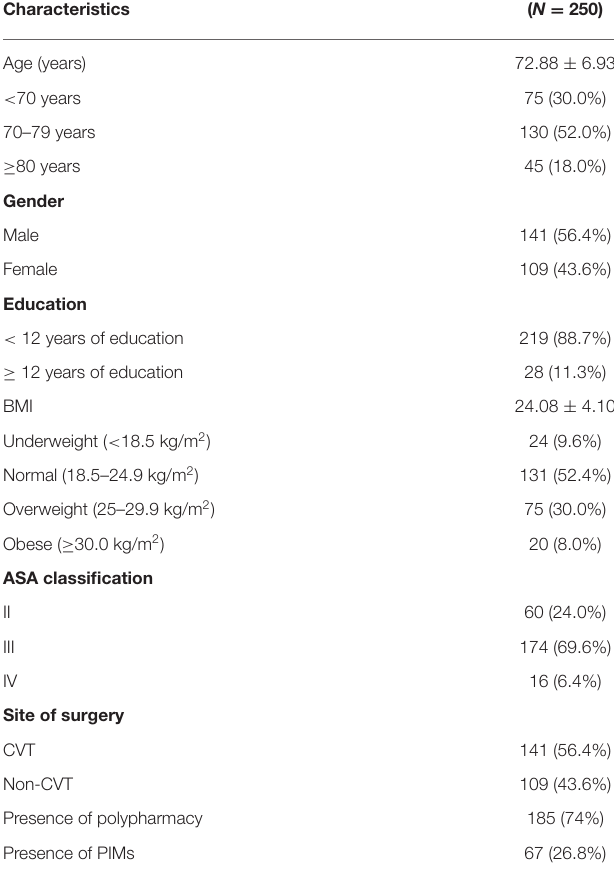
TABLE 1 | Preoperative characteristics of the study